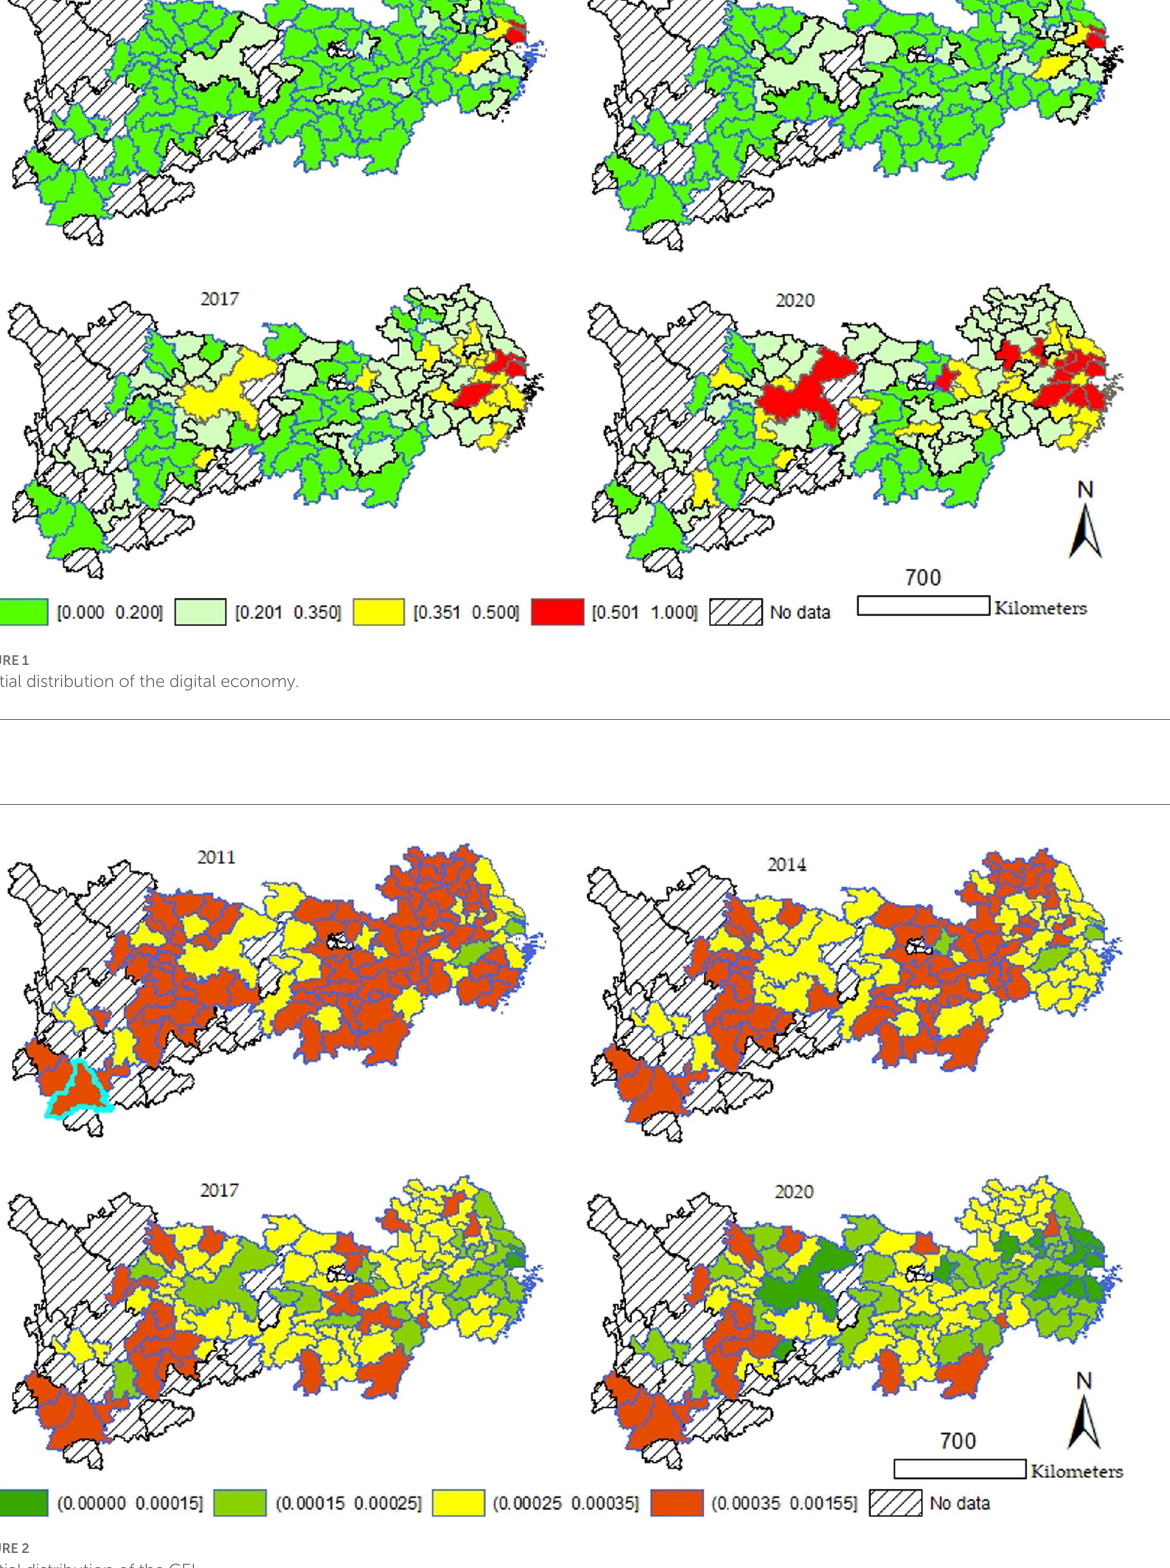
FIGURE 2 Spatial distribution of the